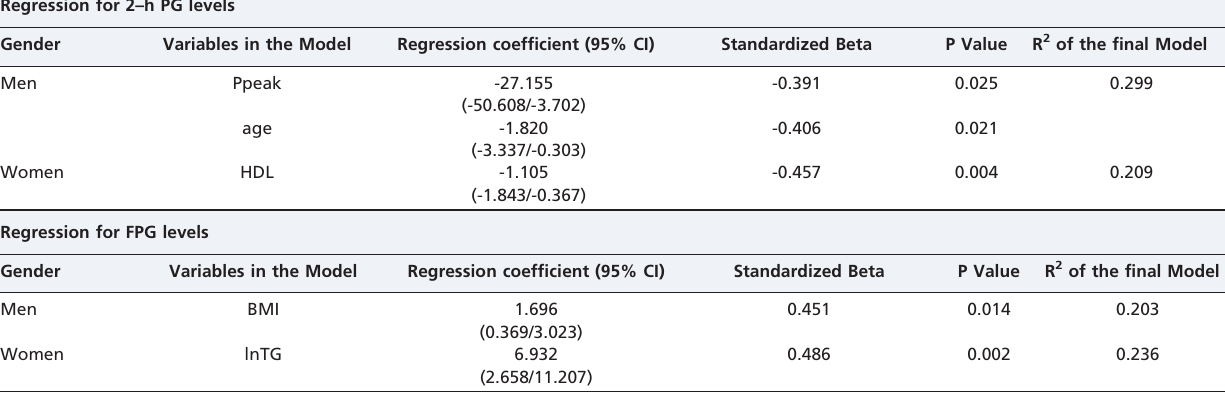
Table 2 - Summary of the stepwise regression with backward variable selection for the 2–h PG and FPG levels. Regression for 2–h PG